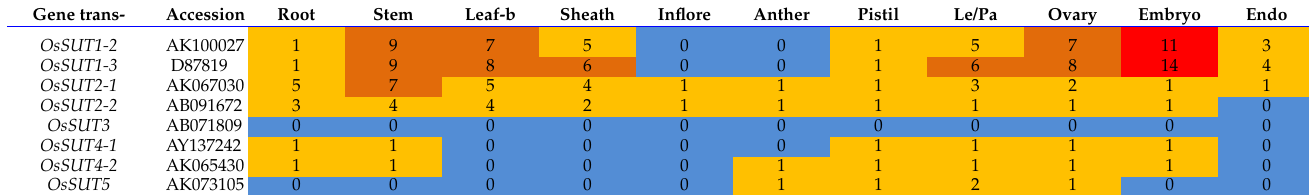
Red squares represent strong expression; brown squares represent medium expression; yellow squares represent weak expression; blue squares represent no or only marginal expression. Numbers in squares represent relative intensities of gene expression. Leaf-b: leaf blade; Infore: inflorescence; Le/Pa: lemma/palea; Endo: endosperm. NA: data not available. Hyphenated and numbered genes denote different